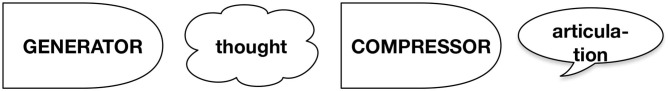
The Meaning First approach to language assumes that structural representations are generated outside of language and then realized by a compressor for communication.